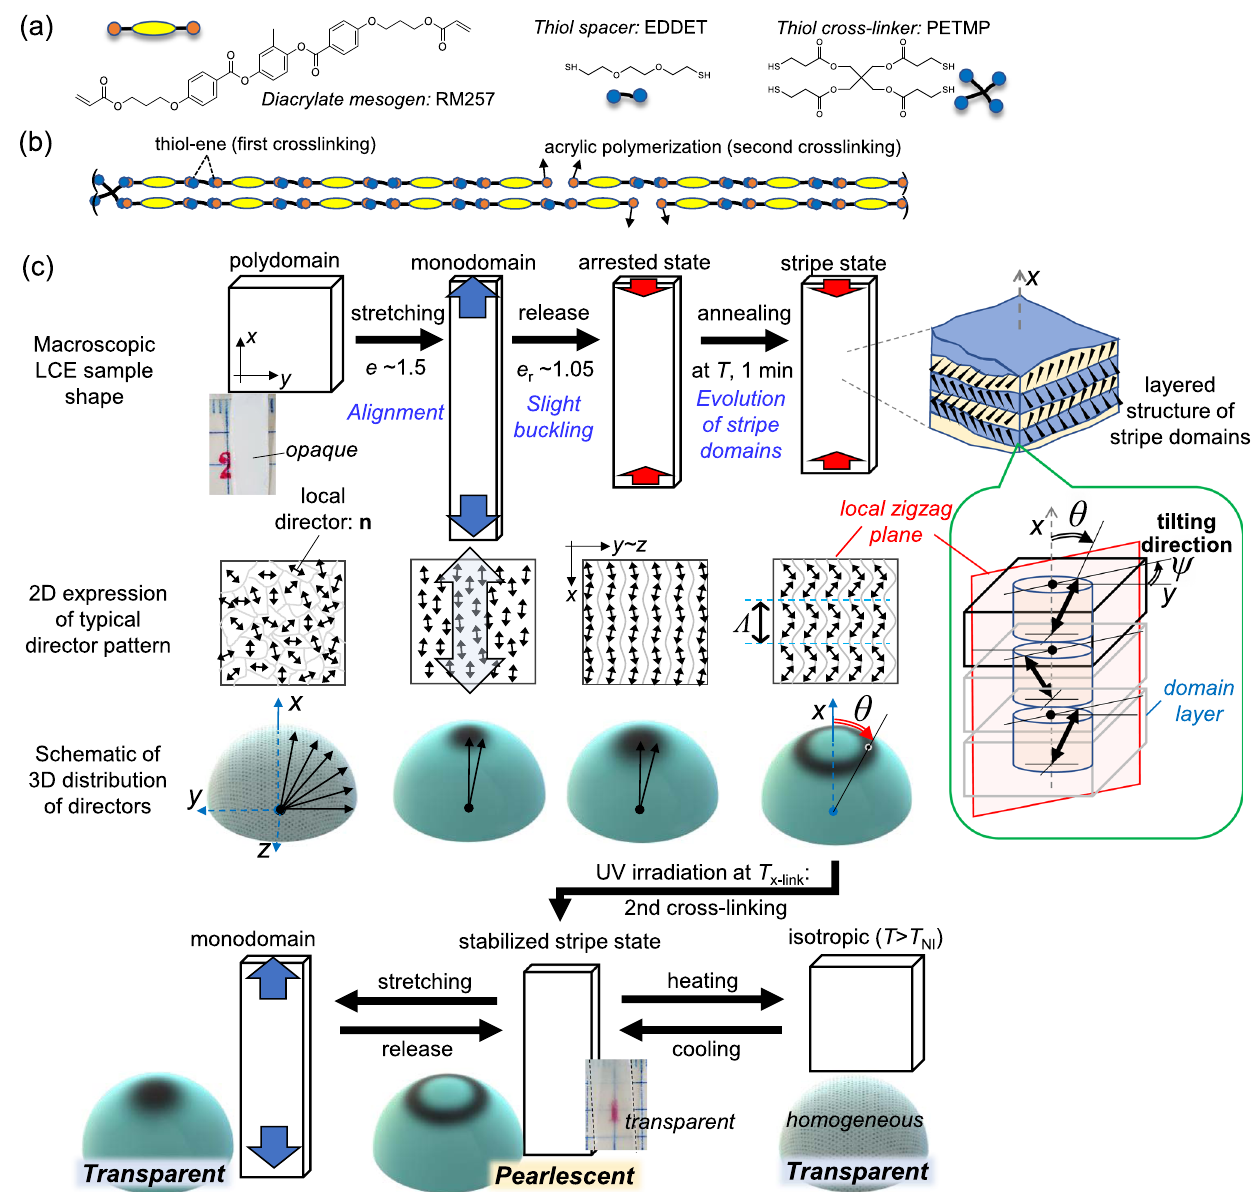
Fig. 1 Preparation of LCEs with stabilized director patterns. a Chemical formulae of the main-chain LCE components. b Schematic of a nominal polymeric unit. c Detailed illustrations of the preparation and director states of the LCEs showing the macroscopic sample shapes, typical director patterns, and their distributions on a